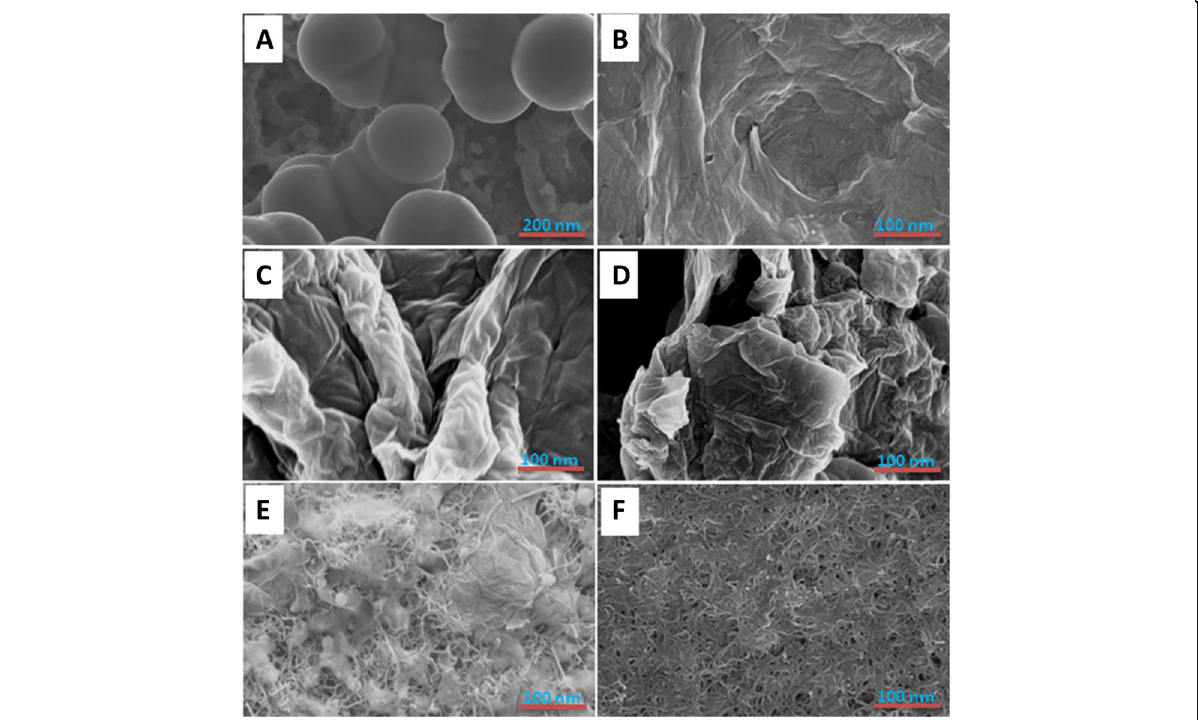
Fig. 1 FE - SEM images of PPy ( a ), GO ( b ), ErGO ( c ), ErGO/PPy ( d ), ErGO/MWCNTs/PPy ( e ), and MWCNTs ( f )